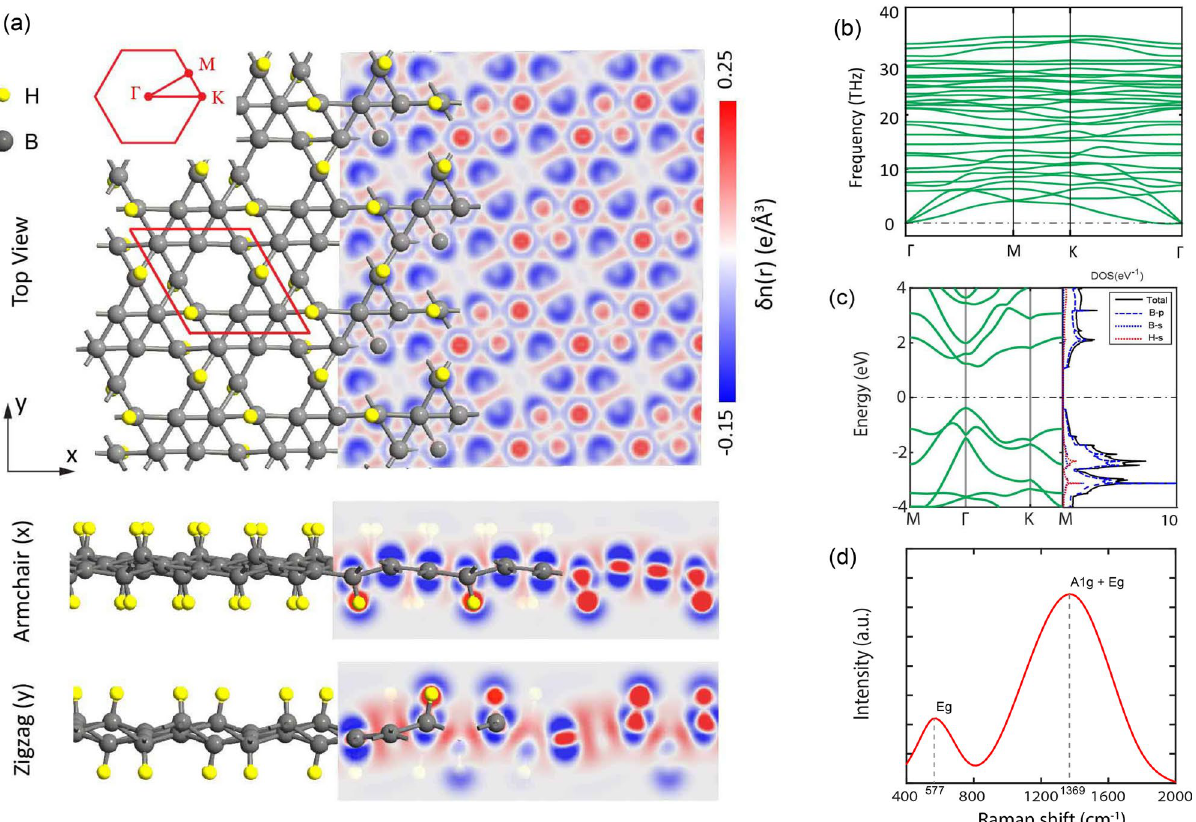
Figure 1. ( a ) Top and side views of the α ′ -4H borophene together with electron difference density map. The x and y axes correspond to the armchair and zigzag directions, respectively. The unit cell and corresponding Brillouin zone are also shown. ( b ) Phonon dispersion spectrum of the α ′ -4H borophene. ( c ) Electronic band structure and density of states (DOS) of the α ′ -4H borophene. ( d ) Raman spectrum of the α ′ -4H borophene.